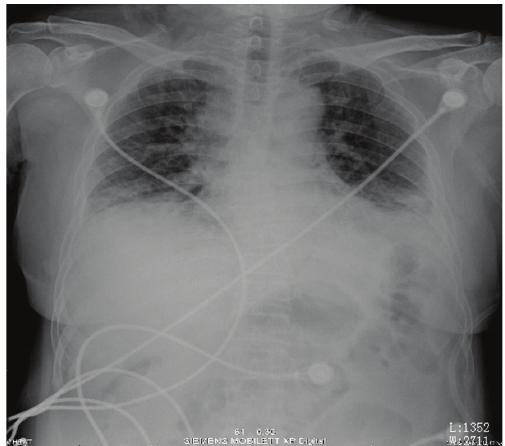
Figure 1: Chest radiograph with remarkable reduction of lung volume as well as increased lung markings.